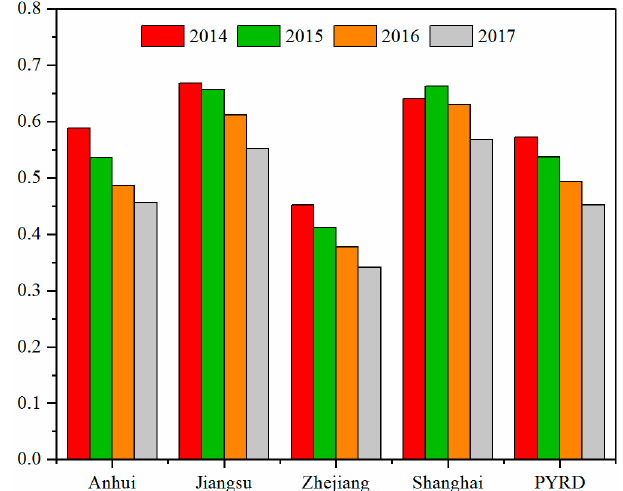
Figure 7. Annual average AOD over the PYRD from 2014 to 2017. Figure 7 . Annual average AOD over the PYRD from 2014 to 2017.